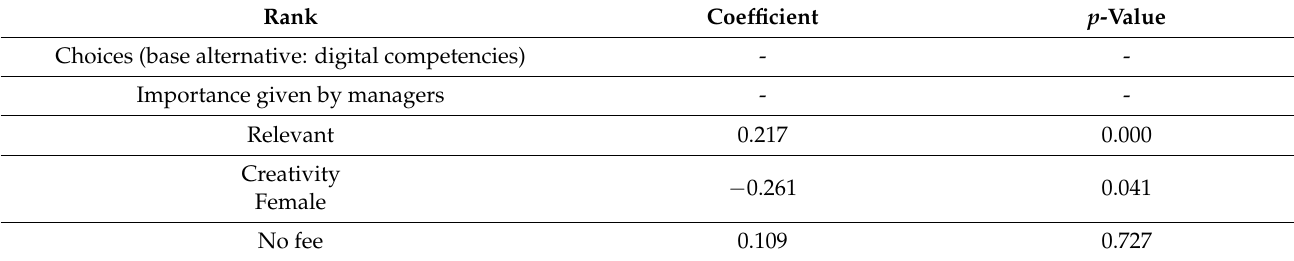
Table 3. The results of rank-ordered probit choice